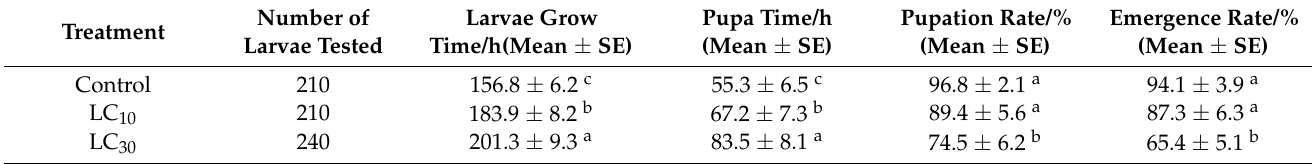
Table 2. Sublethal effects of total alkaloid extracts (TAEs) from Peganum harmala seeds on the second- instar larval